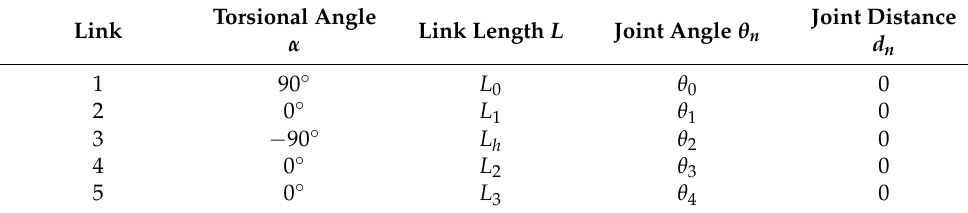
To better control the movement of the robot, the position of each joint corresponding to the robot foot trajectory must be predetermined. Assuming that the spine swings at a constant speed, and denoting θ max the maximum rotational angle of the left trunk end, the swinging angle θ 0 as a function of time t can be expressed by